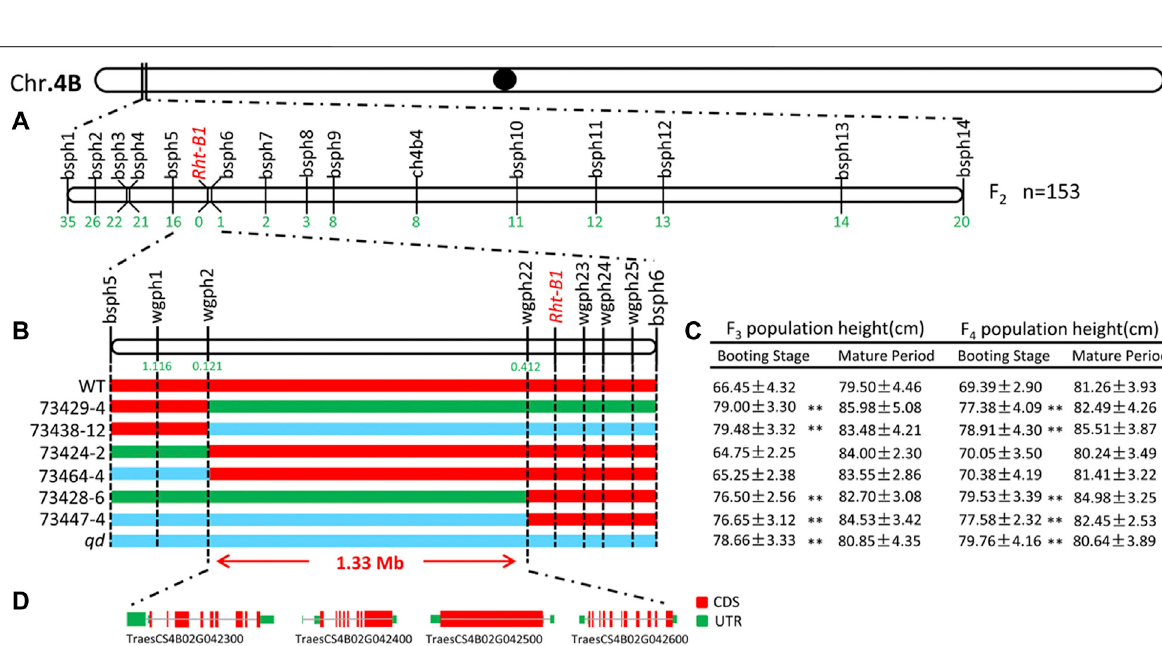
FIGURE 6 | Fine mapping of the qd1 gene. Note: (A) Validation of the qd1 target interval via the F 2 population. The numbers below the vertical lines represent the numbers of recessive single-strand recombinants in the F 2 population. (B) Genotyping of the F 3 and F 4 populations. Red indicates the WT genotype, green indicates the heterozygous genotype, blue indicates the qd genotype, and the numbers below the vertical lines represents the recombination frequencies. (C) Phenotypic data of the plants composing the F 3 and F 4 populations. “ ** ” indicates differences between the populations that are signi fi cant at the 0.01 level. (D) Gene annotation within the localization